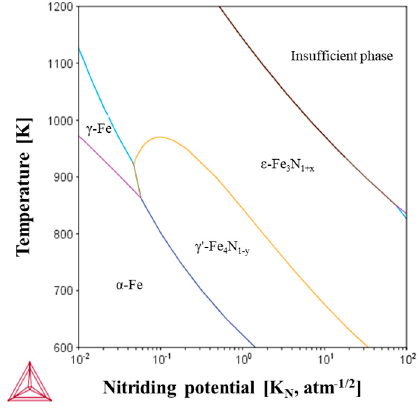
Figure 2. Lehrer diagram which are calculated with Thermo-Calc. software in this study.